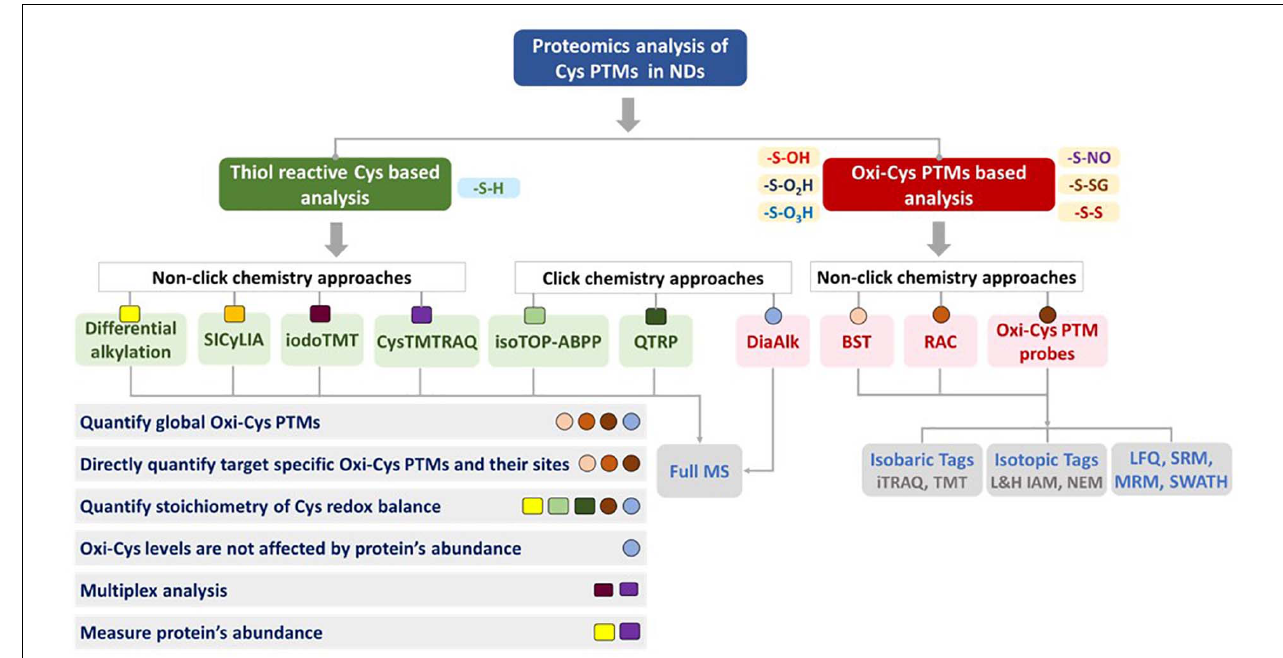
FIGURE 9 | Considerations for choosing strategies for proteomic analysis of cysteine oxidation. Various features of each approach are included to help guide the choice of methods. The shape ( (cid:3) , (cid:13) ) and color code each represent a distinct method but are grouped according to the different overall